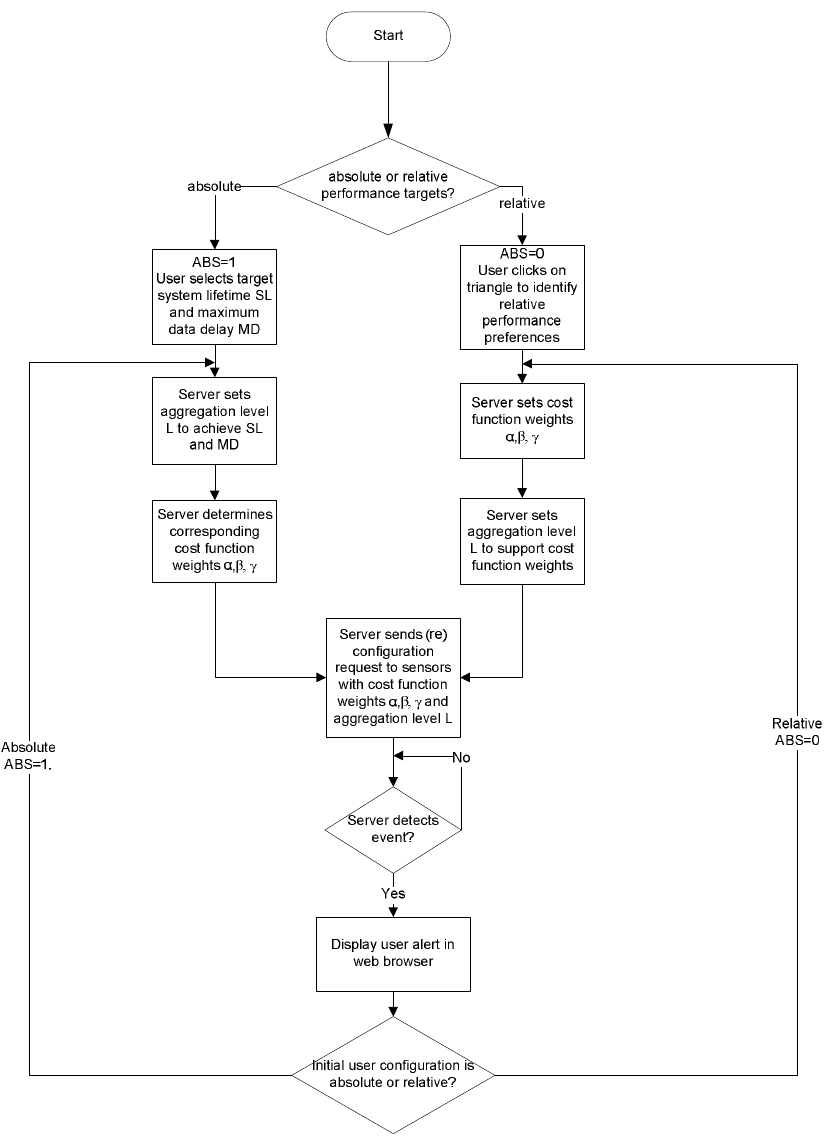
Figure 4. The feedback mechanism at the SUMAC